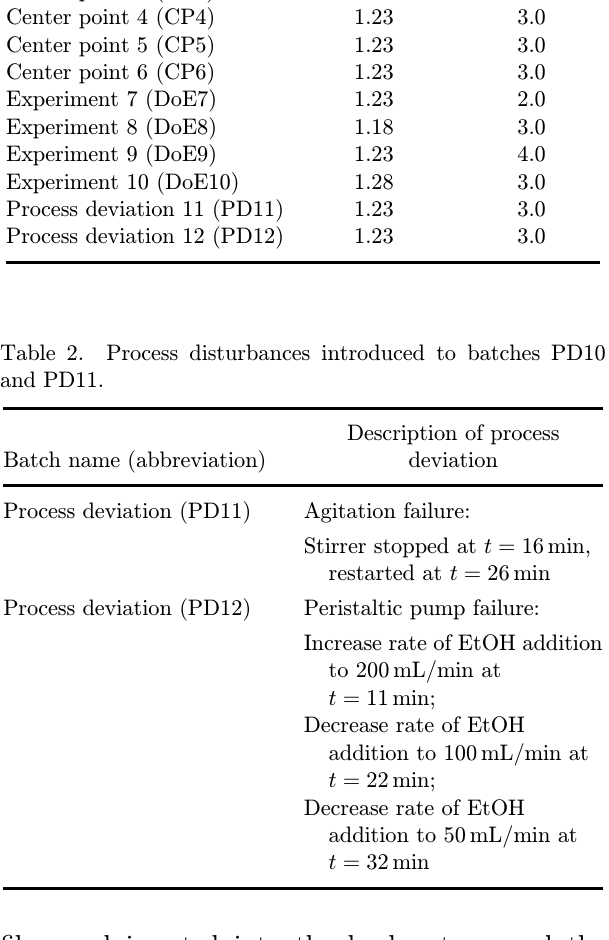
Batch name (abbreviation)